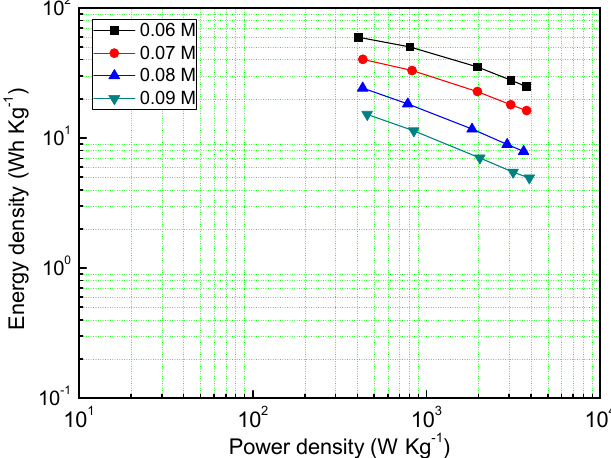
Figure 6. Energy density of di ff erent samples at di ff erent power